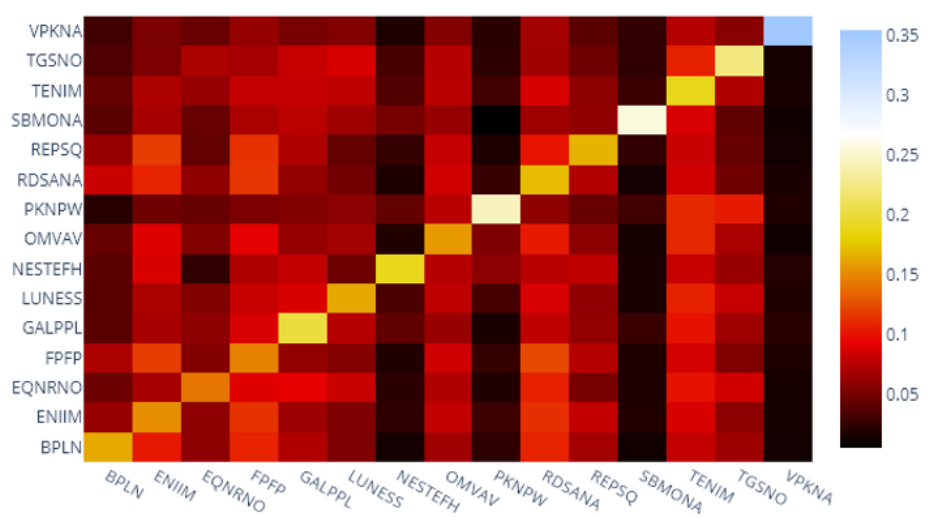
Figure 2. Spillovers across companies inside the energy sector for Delta CoVaR measures — full sample.